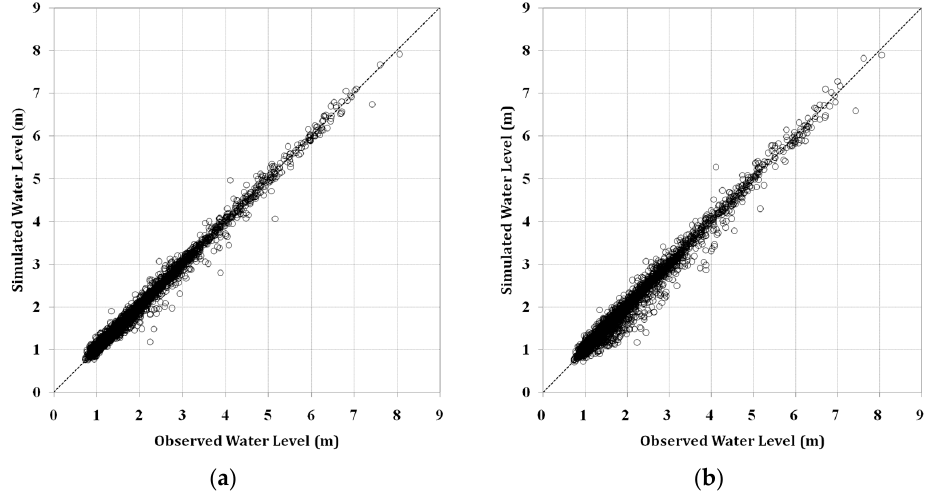
Figure 11. Scatter plots of observed and forecasted water levels with a lead-time of 1 h. ( a ) ANN1d; ( b ) ANN1a.